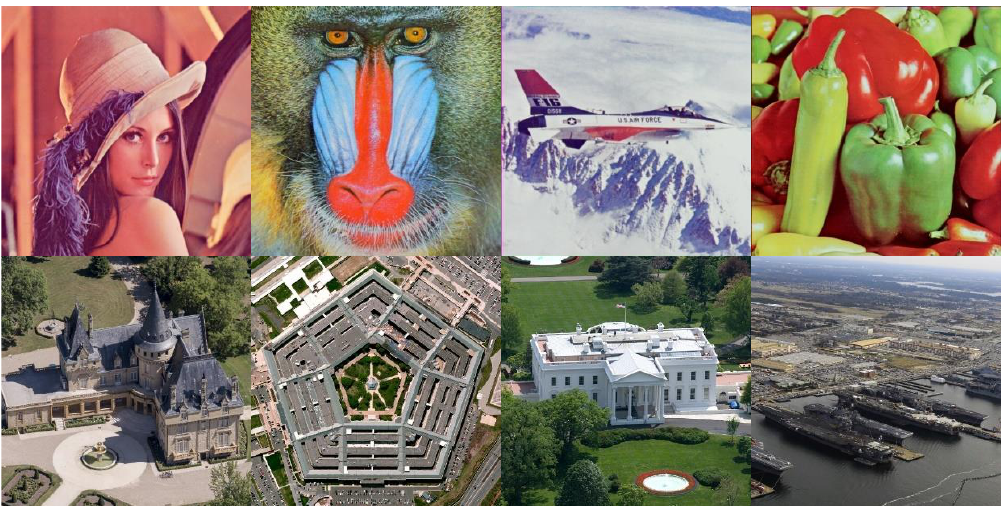
Figure 2. Host images: Lena, Baboon, Airplane, Peppers, Building, Pentagon, White House, and Naval Base.